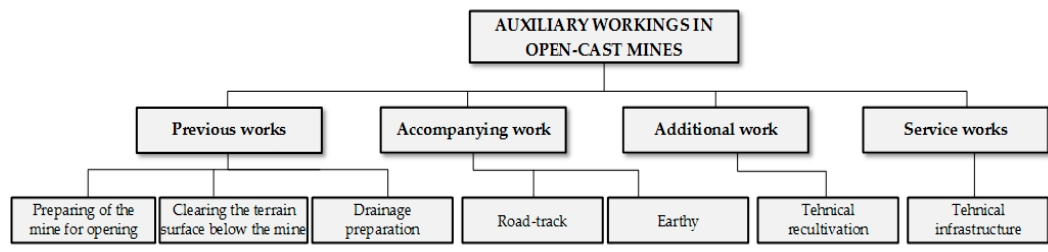
Figure 1. Auxiliary working classification.